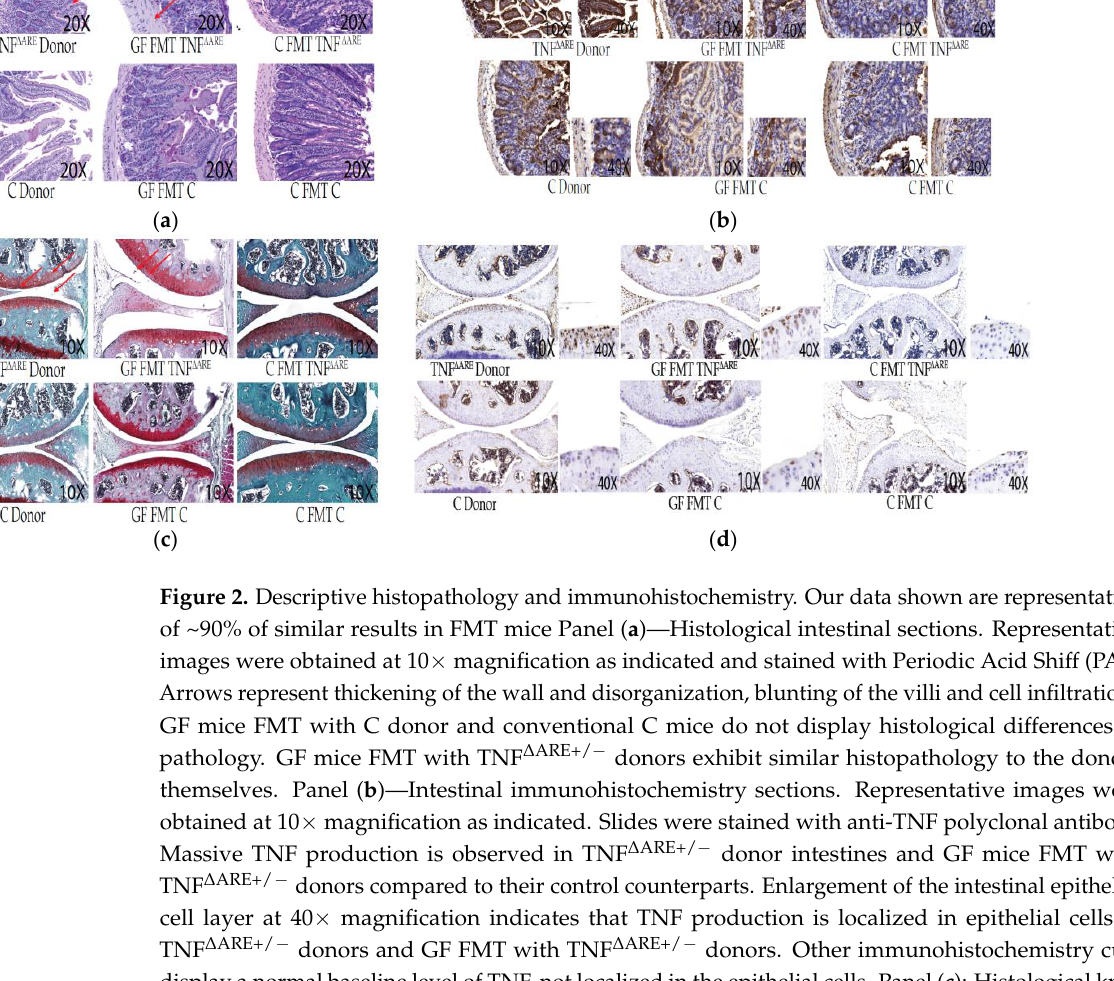
Figure 1. Macroscopic in vivo phenotypes ( a ) — Representative pictures of donor mice. Top: male conventional donor control (C), n = 9. Bottom: male TNF ΔARE+/− sick donor with enlargement of the right lower limb ( n = 11). TNF ΔARE+/− donor exhibits a degenerative arthritis with deformation and swelling phenotype compared to control. ( b ) — Picture of GF mice, that received FMT from C or TNF ΔARE+/− donor. Top: control GF mice FMT with C donor which exhibit a phenotypically normal paw. Bottom: GF mice FMT with TNF ΔARE+/− exhibiting a phenotype with deformation and swelling similar to the TNF ΔARE+/− donor. Females show the same phenotypic pattern and pictures are repre- sentative of the entire colony. Histological examination of the gut and the joints of these GF male and female mice subjected to FMT with TNF ΔARE+/− fecal matter, shows a degradation of the knee joints (clefts, debris, tears and loss of cartilage) and damages to the gut (thickening of the wall, dis- organization of the villi, cell infiltration) compared to the group of male and female GF mice FMT with C mice, panels , see Figure 2 ( a , c ). Immunohistochemistry (IHC) was then conducted using anti-TNF antibody. In GF mice FMT with TNF ΔARE+/− , as compared to GF mice FMT with healthy microbiome, IHC showed significant pro-inflammatory cytokine signature in tissues, particularly in the gut. We can localize the TNF staining in the gut epithelial layer cells and in the chondrocytes of the cartilage surface (Figure 2, panels ( b , d ) Results were similar between males and females).